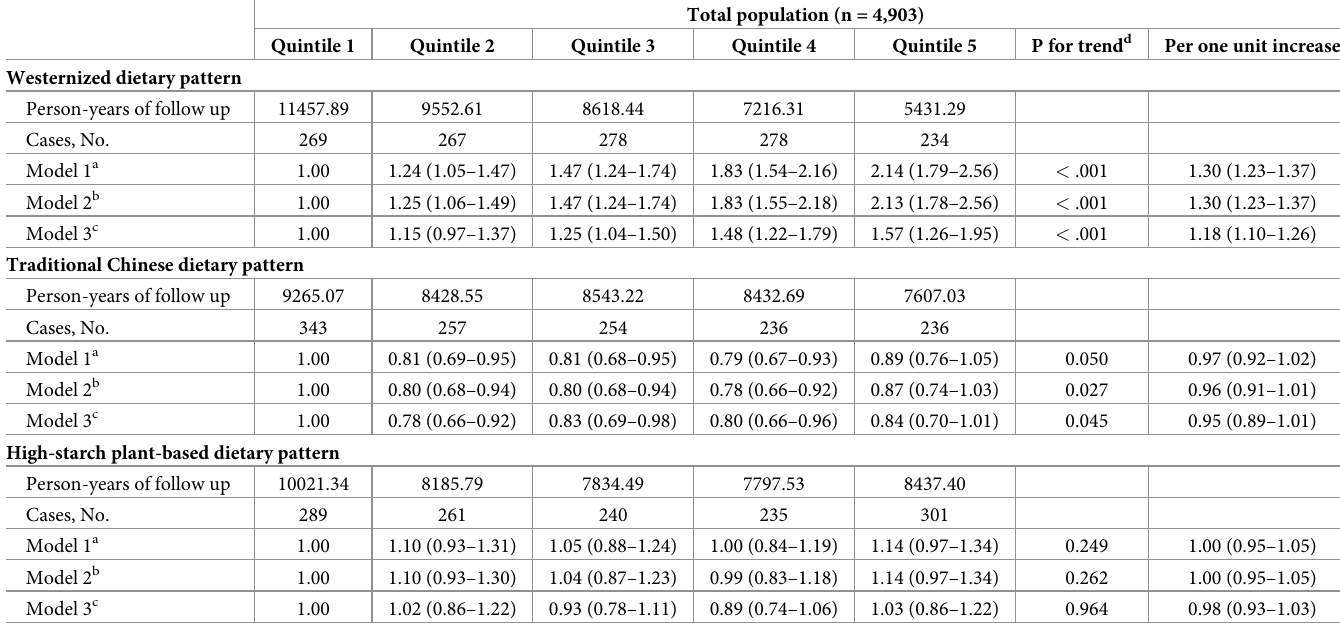
Table 3. Relative risk (RR)s of incident obesity (BMI � 25kg/m 2 ) according to quintiles of dietary patterns in men and women